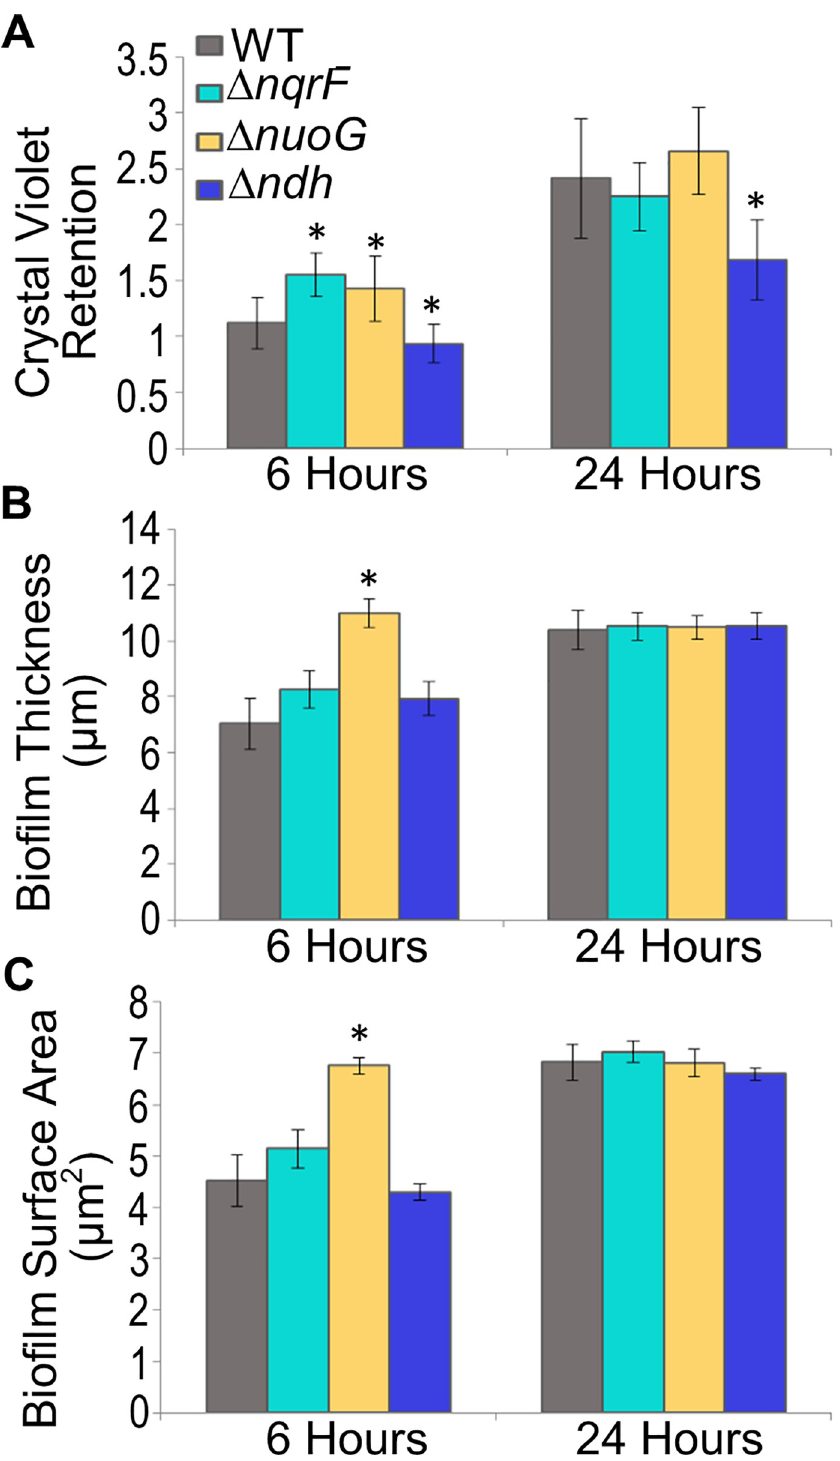
Fig 4. Biofilm formation by wild type (PAO1) and single deletion mutants. A. Crystal violet retention was measured as the total amount of biofilm produced. WT (grey), Δ nqrF (cyan), Δ nuoG (yellow) and Δ ndh2 (dark blue) were diluted to OD 600 = 0.5 from an overnight culture, and grown in a 96-well plate, without shaking for 6 h (mid- attachment) or 24 hours (mature biofilm). Crystal violet retention of the biofilm was examined at each time point through optical density at 600 nm. B. Surface area of the biomass from COMSTAT2 analysis of images taken with two-